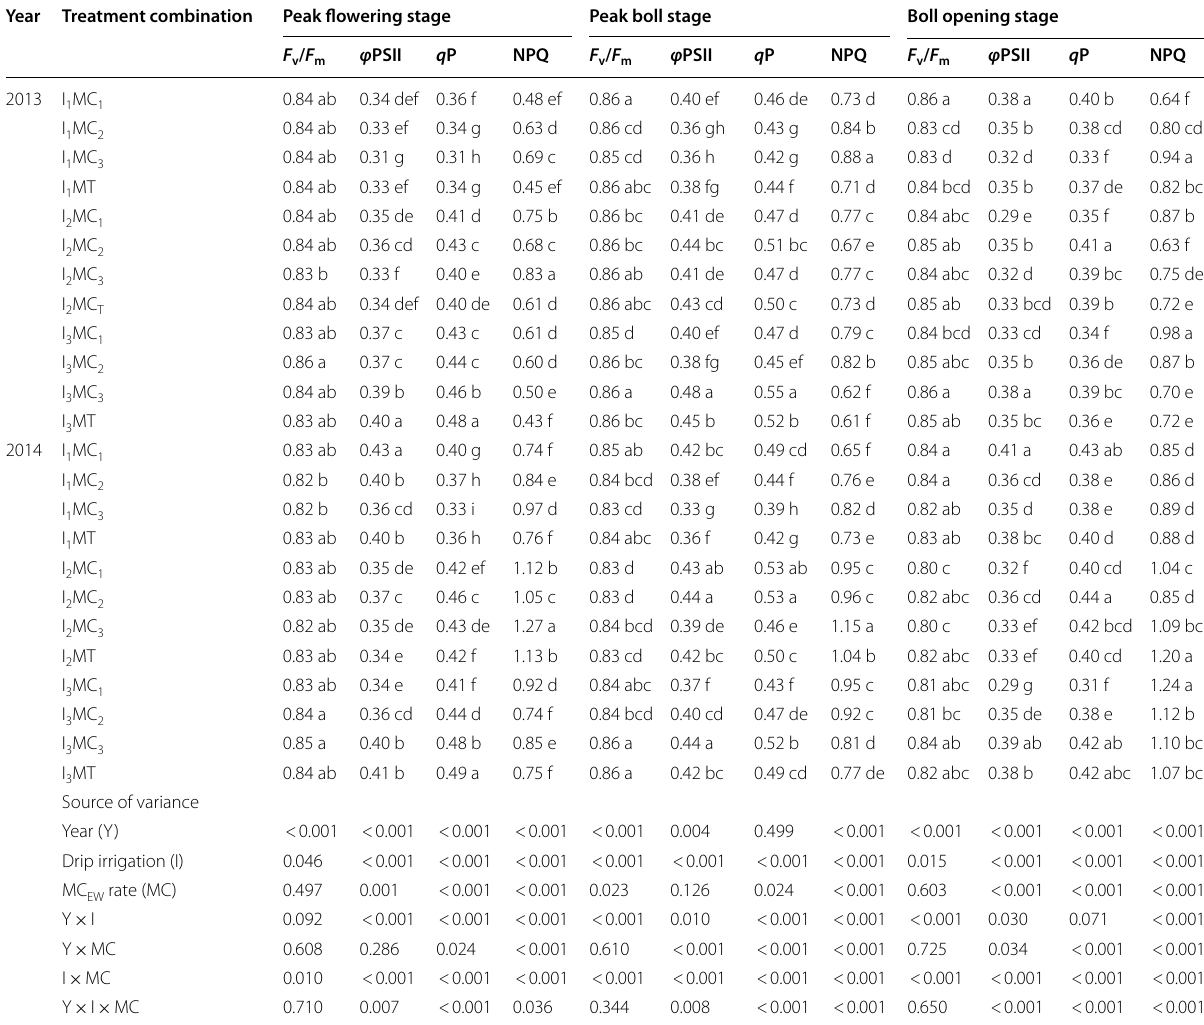
rate (MC) on chlorophyll fluorescence parameter during the cotton growing